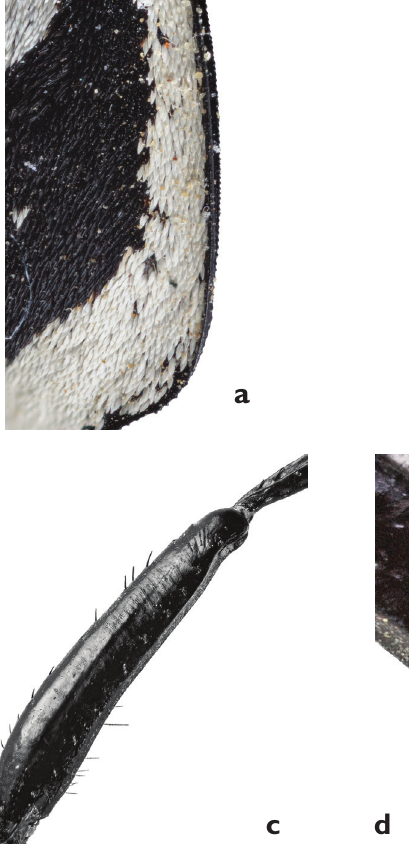
a b Figure 8. Stridulatory structure of Graphipterus serrator : a Serrated epipleural structure on the elytra edge b Magnification of a. c Carina on the upper side of the metafemur d Detail enlargement of c .